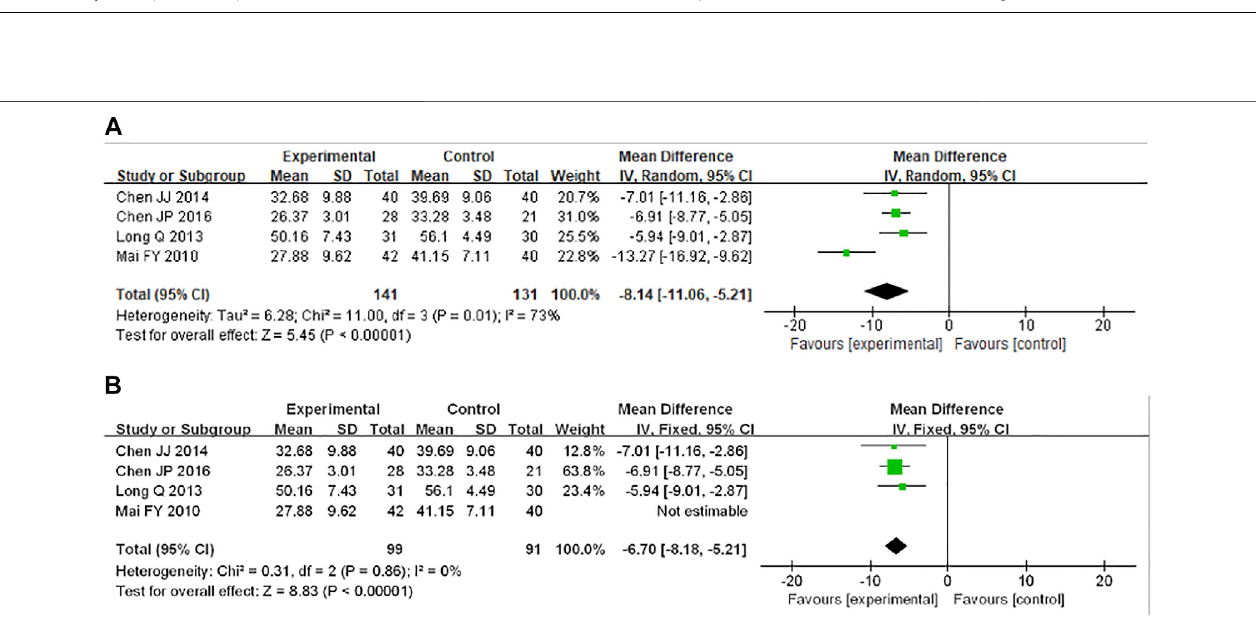
FIGURE 5 | Forest plot of comparison of SAS: XYS combined with western medicine as an adjuvant to western medicine for functional gastrointestinal disorders.